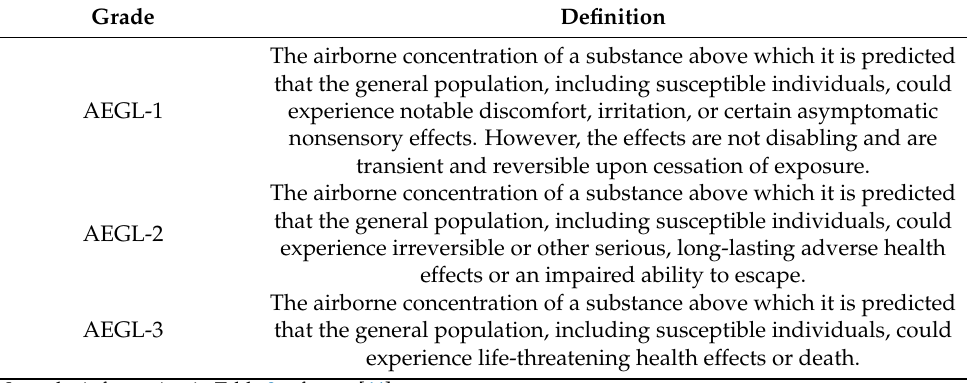
Table 3. Classification of the AEGL injury threshold